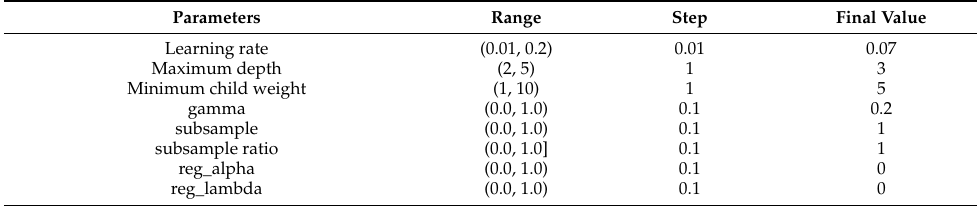
Table 3. In the grid-search method, the ranges of each XGBoost parameter and their